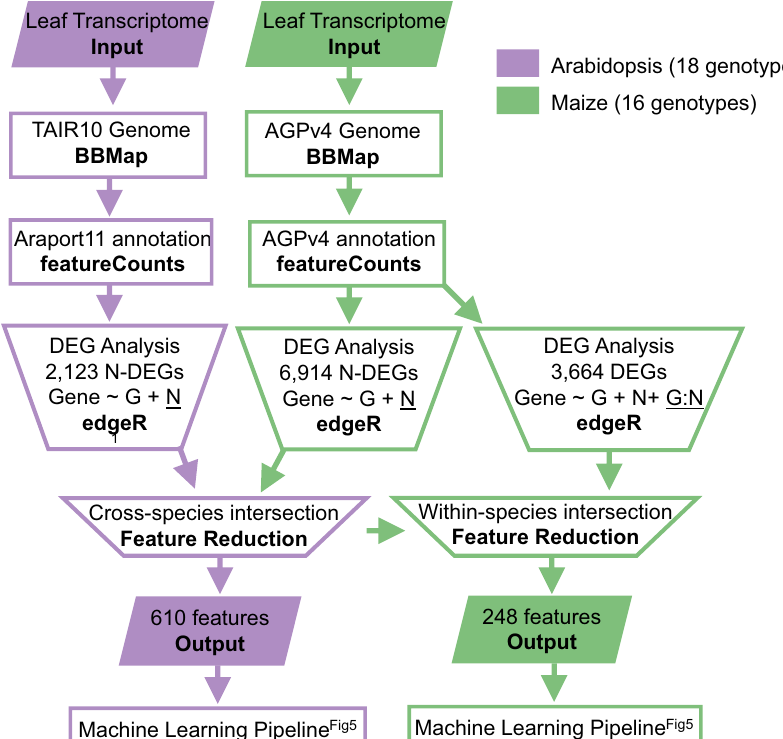
Fig. 4 Evolutionarily conserved N-response genes across Arabidopsis-maize used as a biologically principled feature reduction method for the XGboost machine learning pipeline. The RNA-seq reads from leaves of Arabidopsis and maize N-treated samples were aligned to reference genome assemblies using BBMap and the read counts were generated using featureCounts. The N-response DEGs (N-DEGs) were identi fi ed using generalized linear models in edgeR and leave-out-one method: one genotype (out of 18) was left out during each round of analysis and the intersection of 18 DEG lists was used for feature reduction (For details, see Fig. S4). The overlap of N-DEGs from Arabidopsis ( n = 2123) with maize ( n = 6914) resulted in a set of evolutionarily conserved N-response Arabidopsis genes ( n = 610), which were used as features in the machine learning model. The corresponding conserved N-response genes in maize were further intersected with genes responding to nitrogen by genotype effects ( n = 3664), resulting in 248 maize genes that were used as features in the machine learning model to predict NUE. The complete ranking of DEGs is provided in Supplementary Data